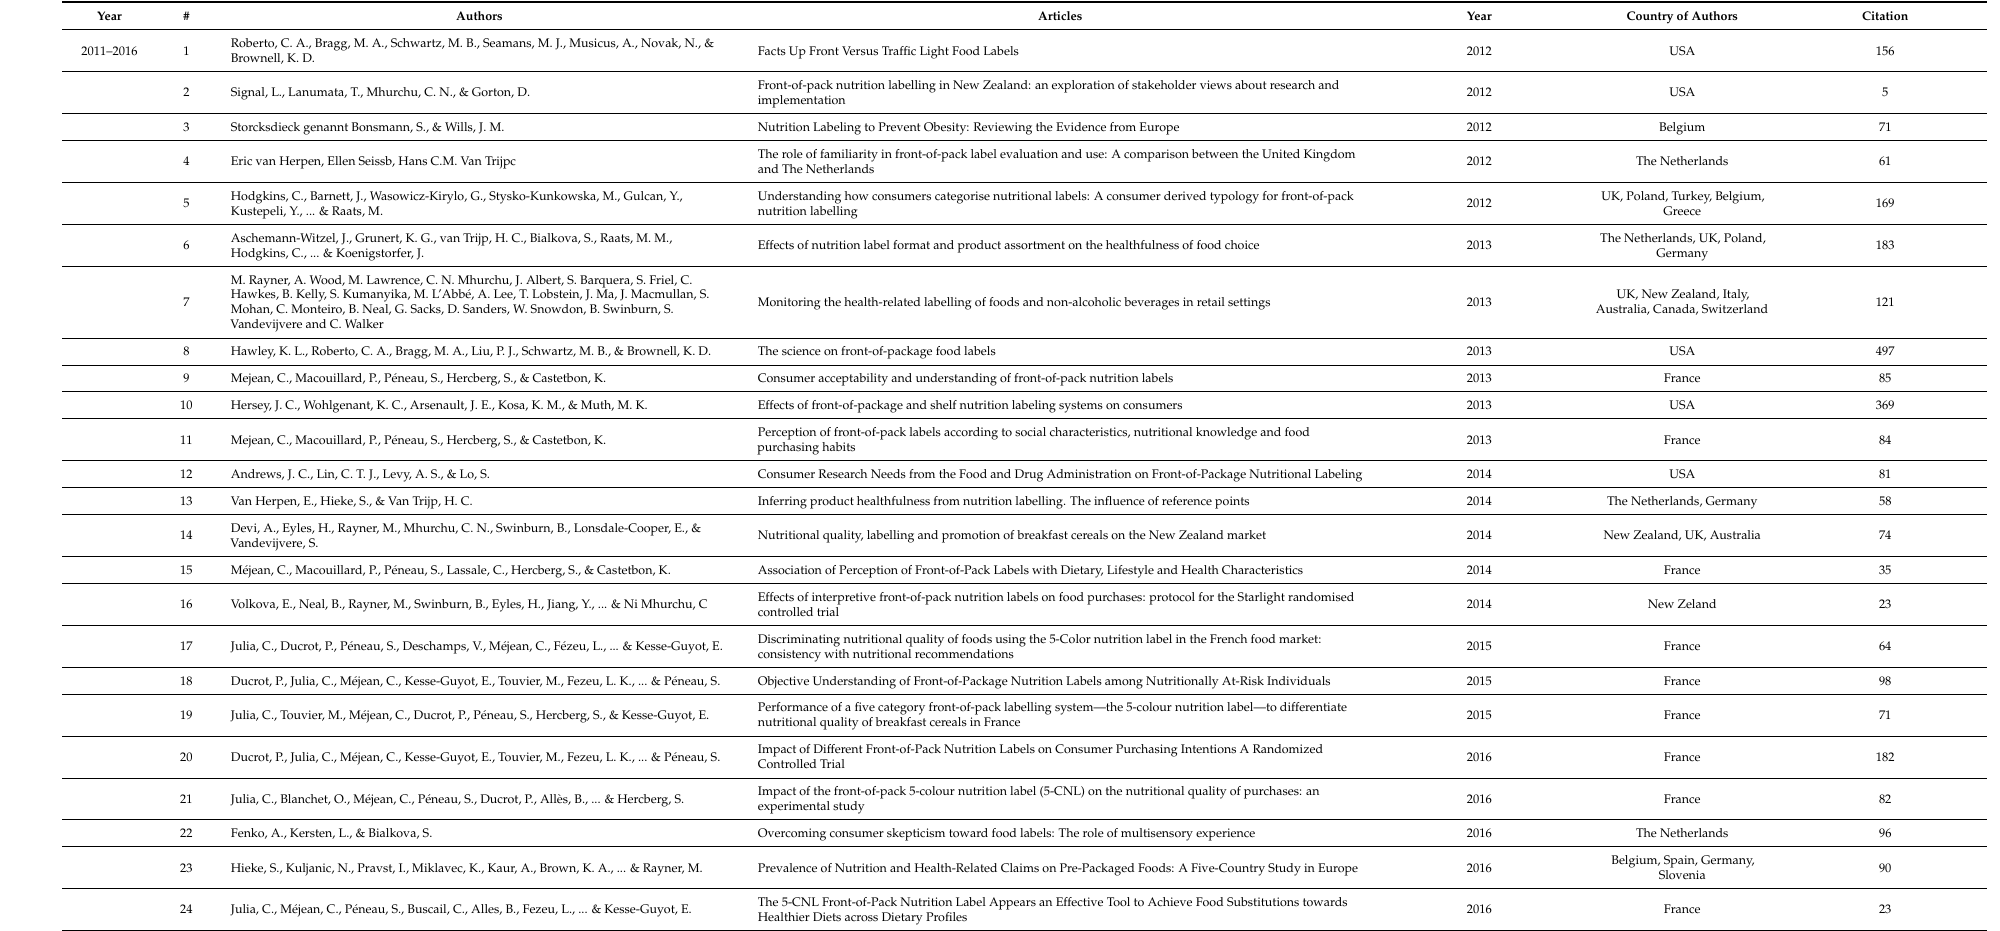
Table 8. Composition of co-citation network 3 in terms of authors, articles, year, country of authors and